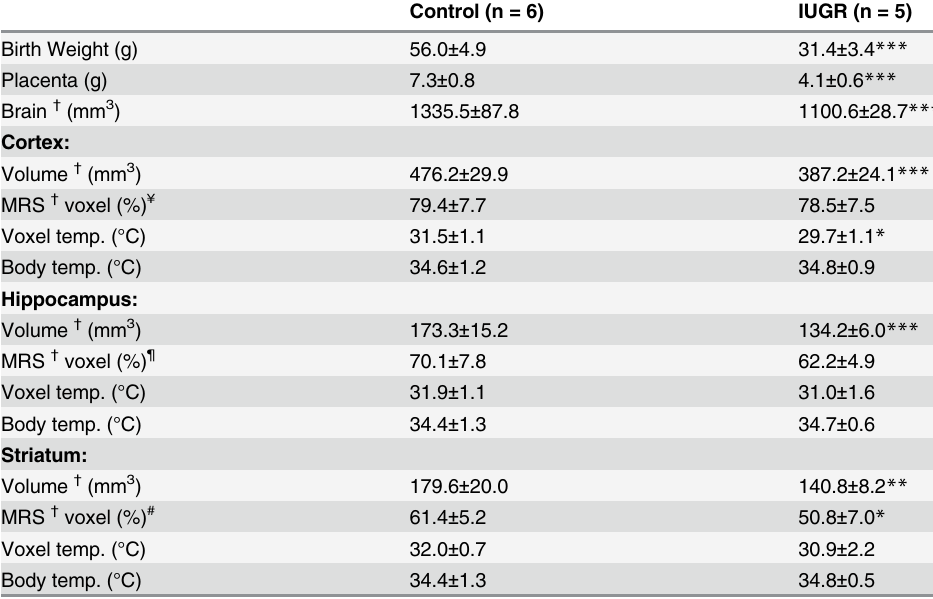
Table 1. Animal cohort used for MR studies ‒ perinatal observations and MRI data. Controls vs IUGR parameters: average birth weight, placental weight, MRS voxel sizes per tissue, and estimated tissue contri- bution in voxel.